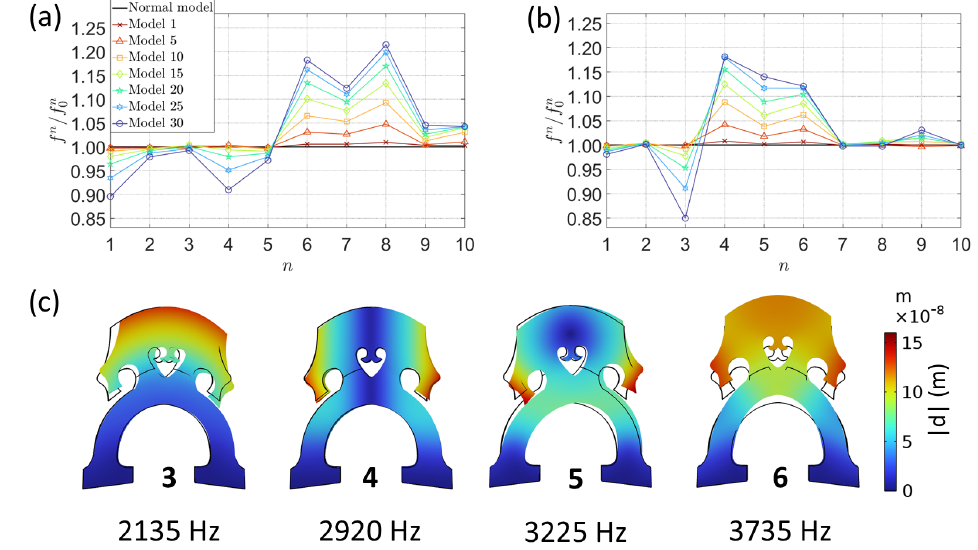
Figure 4. ( a ) Changes in natural frequencies f n in free boundary conditions. ( b ) Variation in natural frequencies f n in fixed boundary condition. Frequencies from different models are shown as a function of the mode number n ; f n is the frequency of the n th mode for the Normal Model. ( c ) Mode 0 shapes and corresponding natural frequencies for n = 3, . . . ,6 in constrained boundary conditions, | d | being the norm of displacement, shown on the Normal